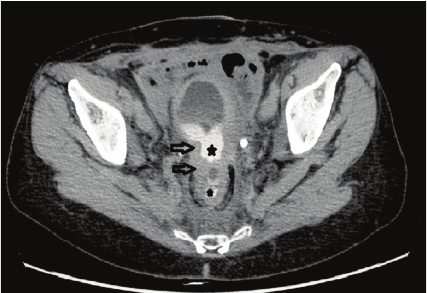
Figure 3: Colovesical fistula: axial image in the delayed phase of CT urogram demonstrates bladder and rectal wall thickening (arrows) with contrast present in both ( ∗